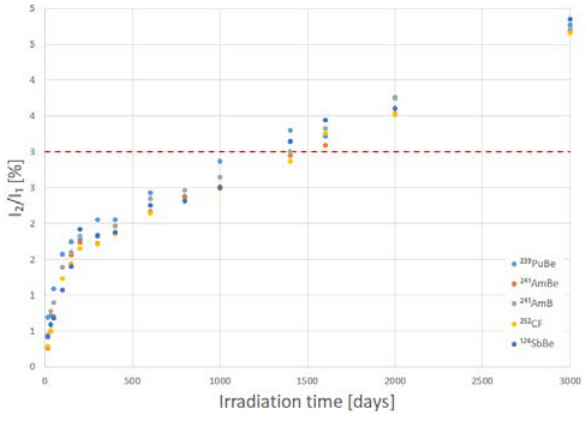
Fig. 7 - Comparison of fission chamber responses for studied sources and various amount of